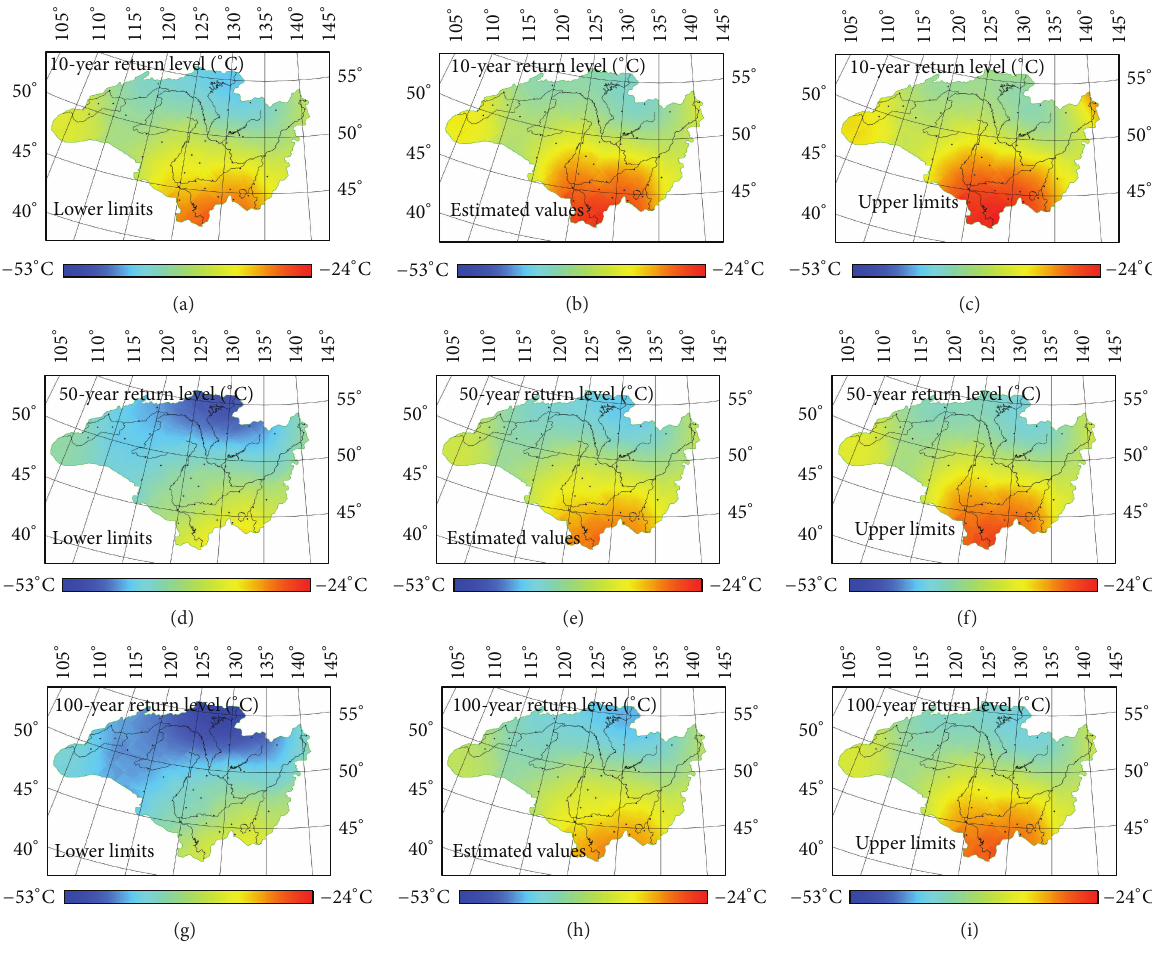
Figure 12: The spatial distribution of (a)–(c) 10-year return level, (d)–(f) 50-year return level, and (g)–(i) 100-year return level for the postchange point subseries of annual minimum temperature, respectively; meanwhile, left, middle, and right columns indicate lower limits, estimated values, and upper limits of multiyear return levels,